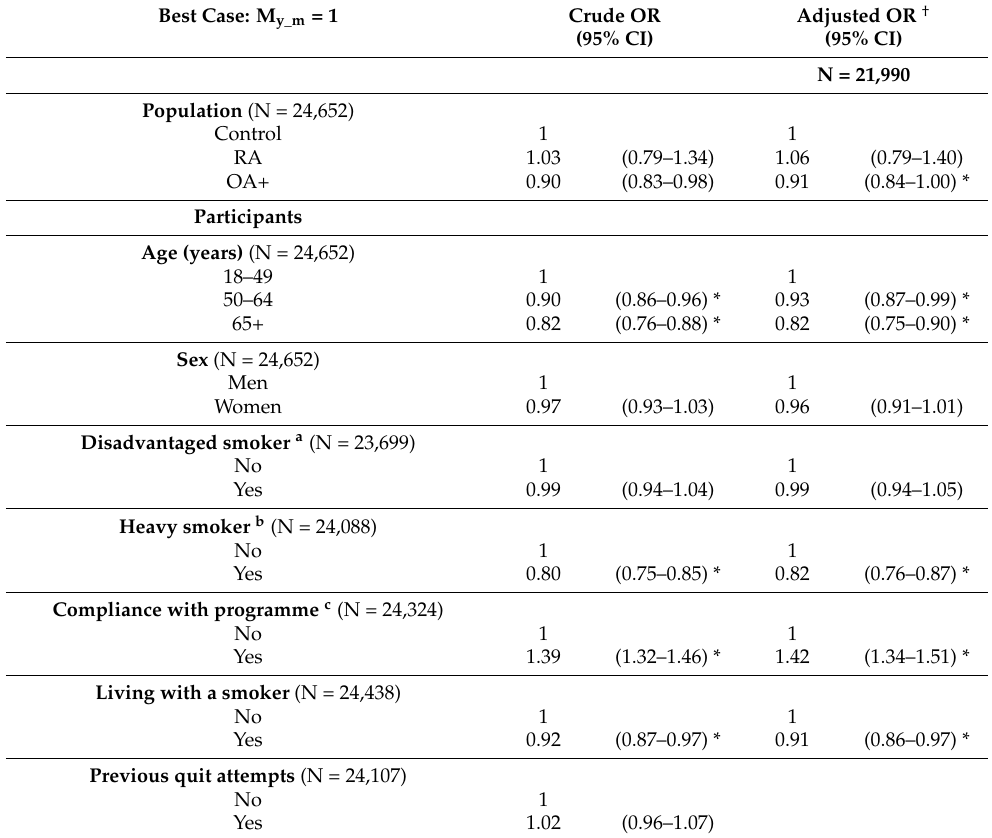
Table A2. Odds ratio (OR) for predictors of continuous abstinence at 6 months, based on a best-case analysis, where all patients lost to follow up were assumed to be